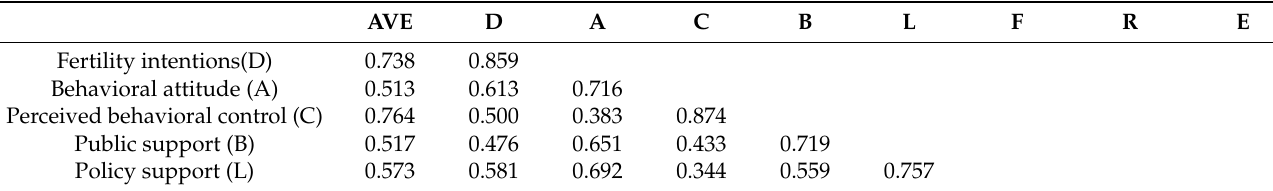
Table 7. Distinguishing validity